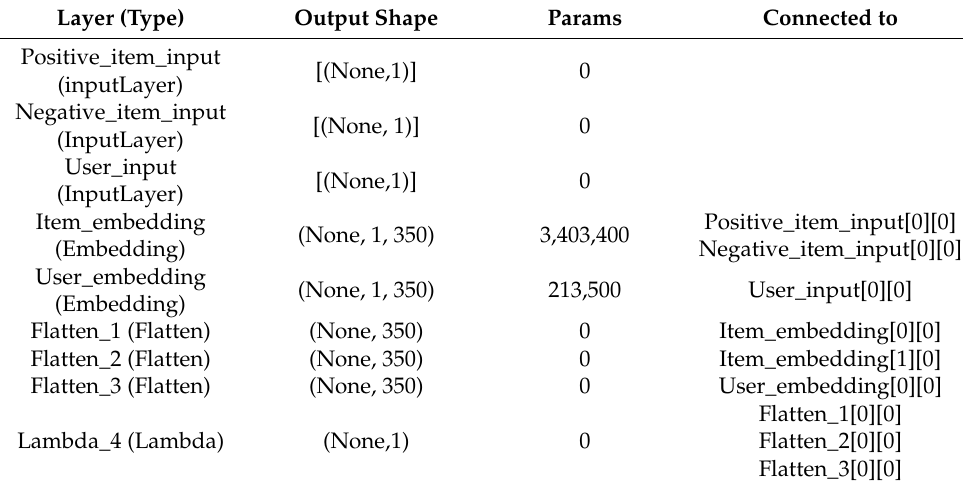
Table 1. Network layers.